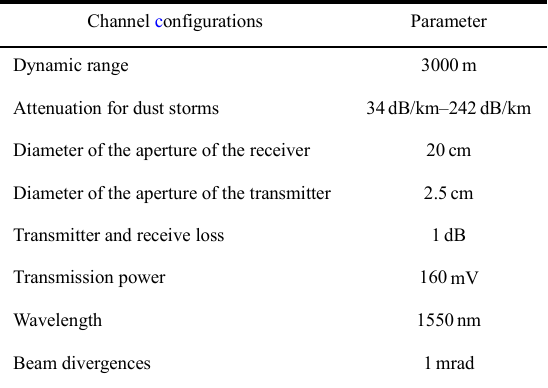
Table 2 FSO link parameters.